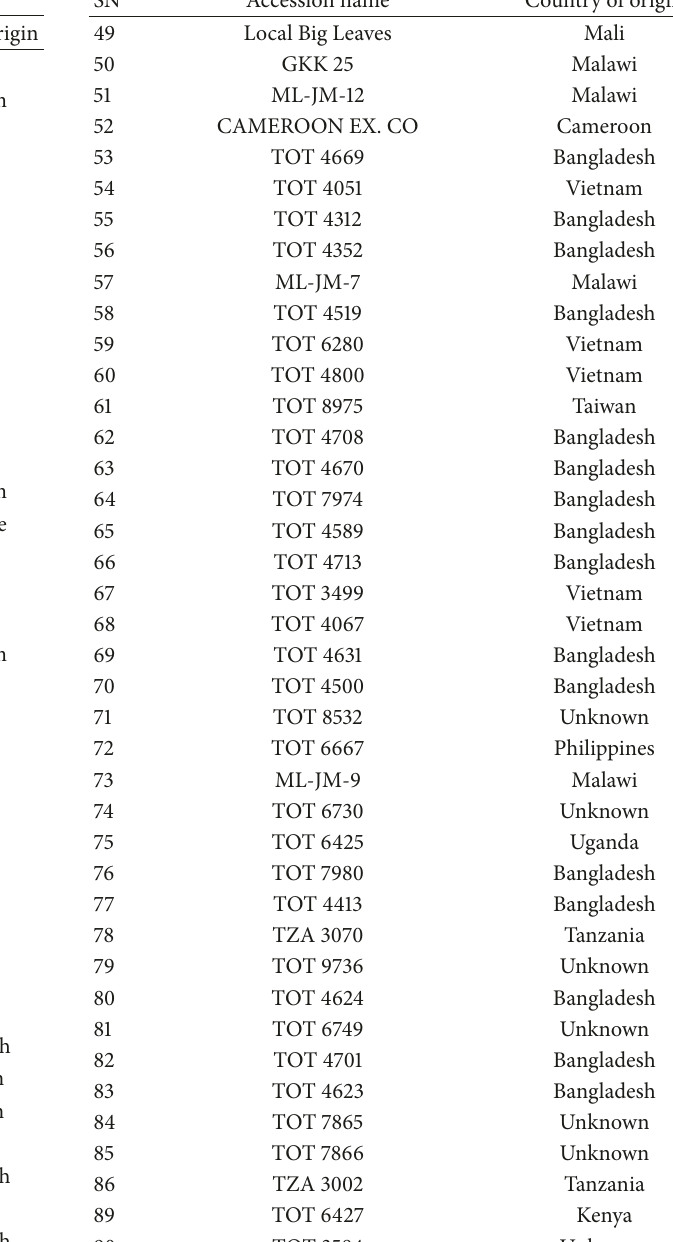
Table 1: The list of Jute mallow accessions (Corchorus spp.) used in this